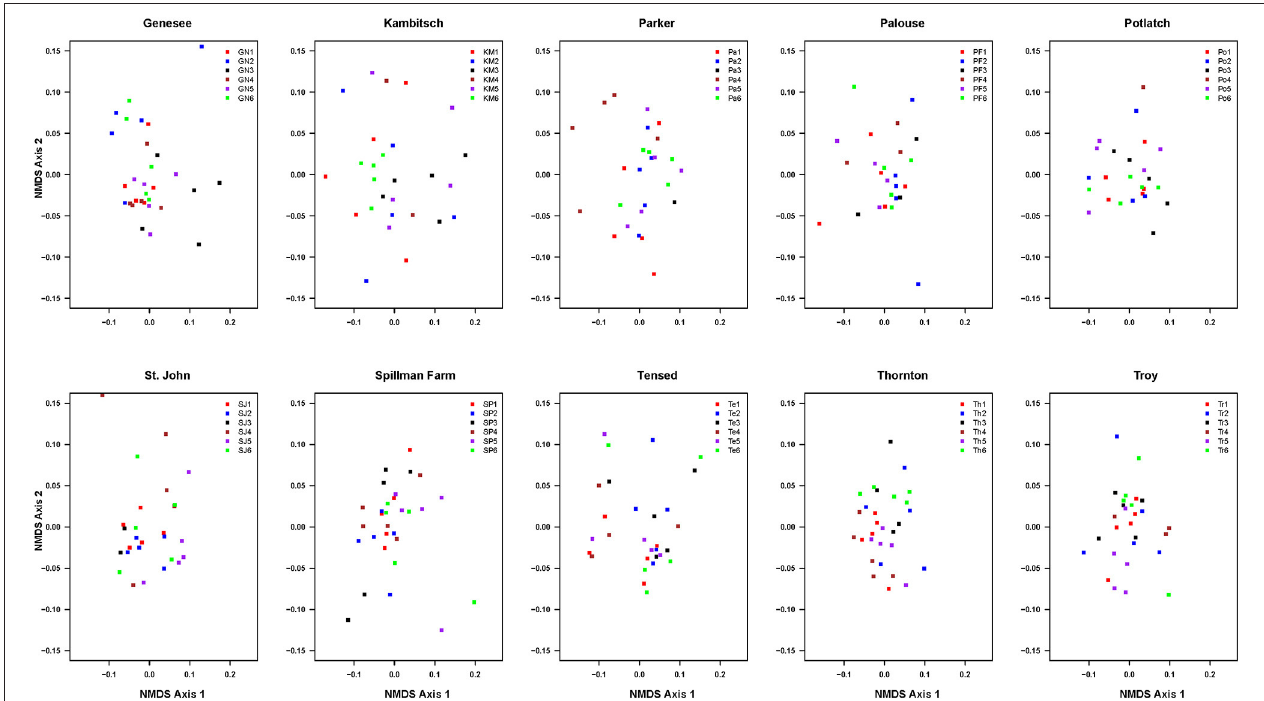
FIGURE 1 | Non-metric multidimensional scaling (NMDS) ordination of selected phenotypic traits [plant height, the total number of branches, first budding date, first flowering date, anthesis, plant life, flowering period, last day of flowering, the total number of flower heads, and plant dry biomass (g)] of half-sibs among six families across 10 Anthemis cotula populations (See detail statistics for each population in Table 2 ).